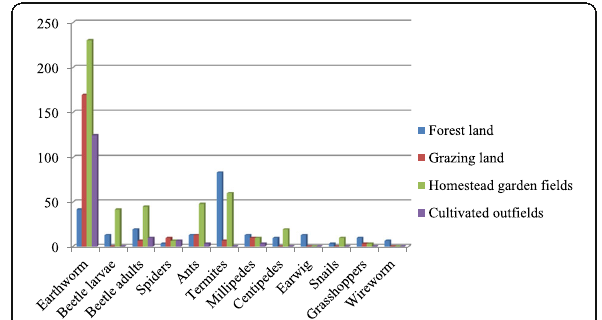
Fig. 3 Density of soil invertebrate macro-fauna in different land use types at Shenkolla watershed, south central